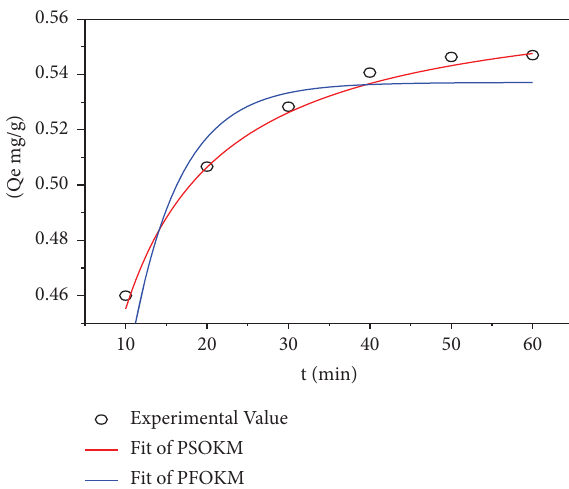
Figure 15: Nonlinear regression of adsorption kinetic models.